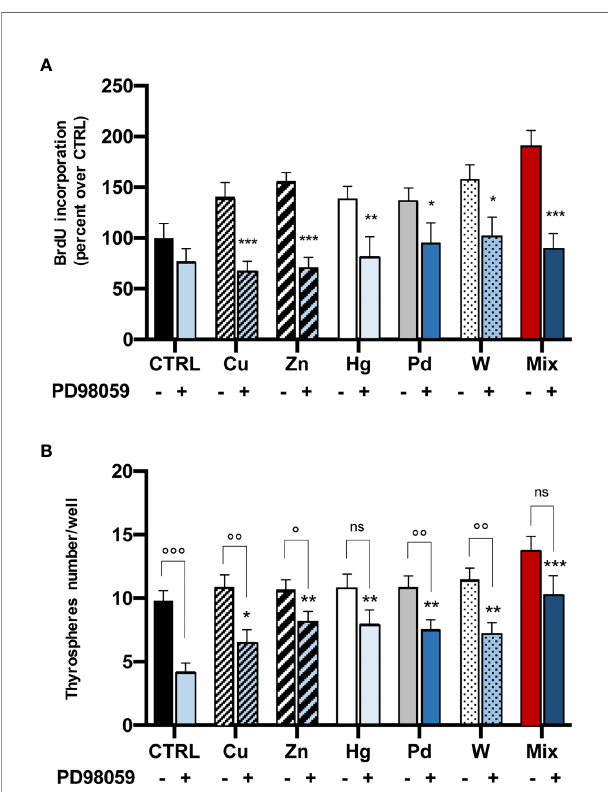
FIGURE 4 | Effect of the ERK1/2 inhibitor PD98059 on metal-induced BrdU incorporation (panel A, cell proliferation) and secondary thyrospheres ’ formation (panel B). (A) Histograms represent the mean value ± SEM of three separate experiments. For each metal and their mixture values are expressed as percent of CTRL (untreated thyrospheres). After thyrospheres ’ exposure to metals for 3 days in the absence or the presence of PD98059 (20 µM) BrdU incorporation was signi fi cantly iblunted in all cases by the inhibition of the ERK1/2 pathway. *p < 0.05; **p < 0.01 and ***p < 0.001 vs. CTRL. (B) Inhibition of the ERK1/2 pathway reduces secondary thyrospheres ’ formation. Cells from dissociated thyrospheres were plated at a density of 3,000 cells in nonadherent 96-wel plates and exposed to metals in the absence or the presence of PD98059 (20 µM) for 8 days. Spheres were counted in 4 wells for each condition. The results are expressed as mean value ± SEM of three separate experiments. *p < 0.05; **p < 0.01 and ***p < 0.001 comparing thyrospheres ’ number in the presence of PD98059 to the number measured under the same condition in control thyrospheres. ns, non signi fi cant; °p < 0.05; °°p < 0.01 and °°°p < 0.001 comparing thyrospheres ’ number in the absence or the presence of